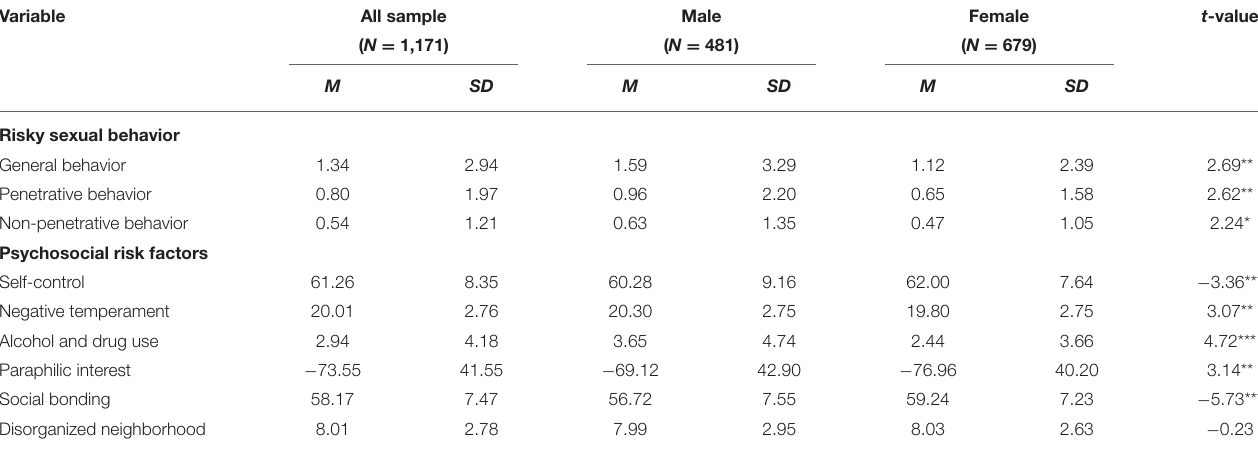
TABLE 2 | Gender differences of the prevalence of self-reported risky sexual behavior and psychosocial characteristics. Variable All sample Male Female